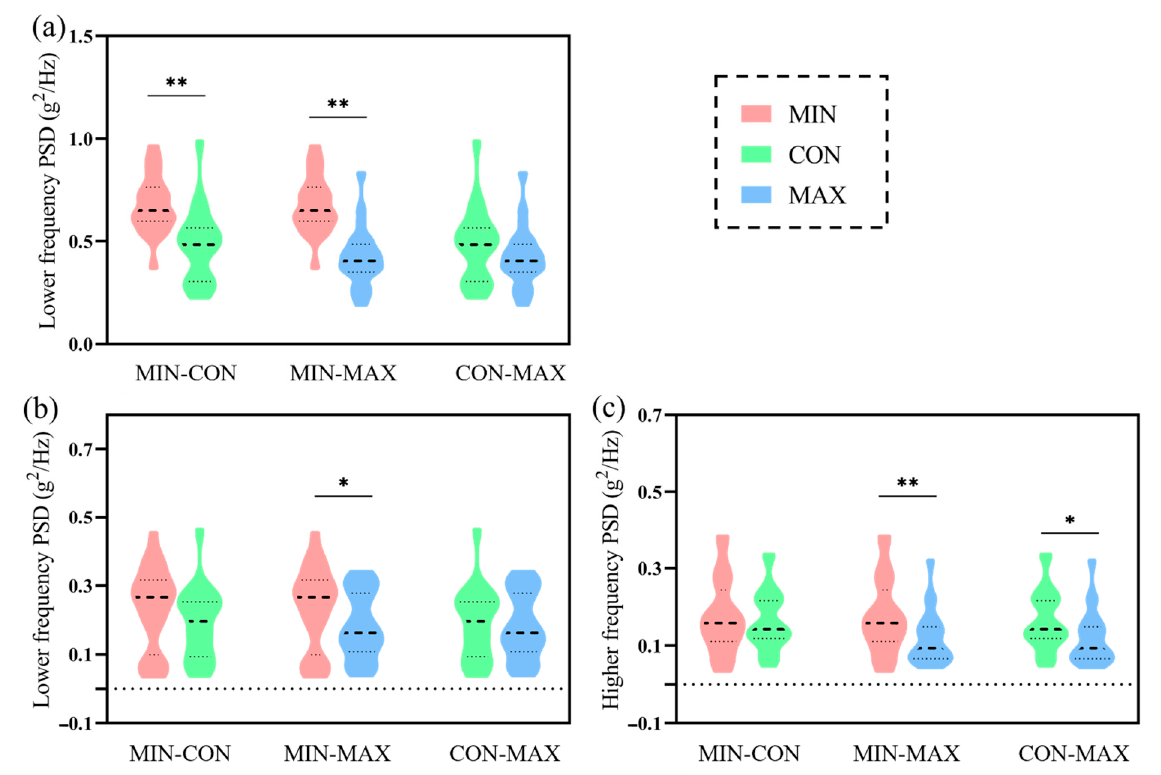
Figure 4. Violin plots of the Bonferroni comparisons for PSD between conditions in the distal ( a ) and proximal ( b , c ) tibia. Note: PSD: power spectral density; MINs: the minimalist shoes; CONs: the conventional shoes; MAXs: the maximalist shoes. * p < 0.05 and ** p < 0.01. The black dashed line represents the median, and the gray dashed lines above and below represent the third and first quartiles.